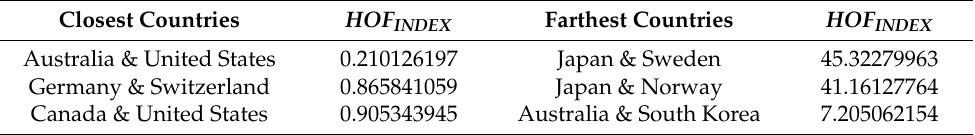
Table 3. Example of the closest and farthest countries in our sample in term of a compound Hofstede index. Source: Authors’